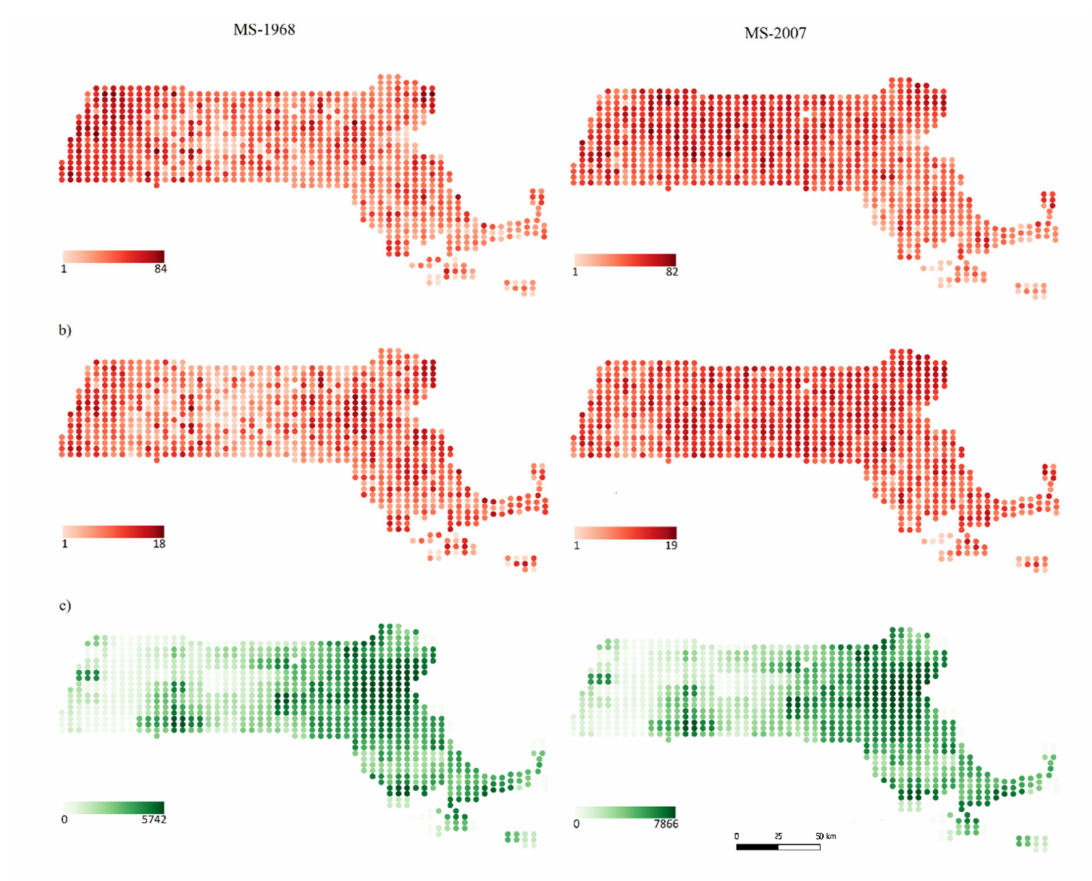
Figure 1. Distribution of ( a ) native species richness, ( b ) alien species richness, and ( c ) human population density in each grid cell (grid cell size approximately 25 km 2 ) in the state of Massachusetts for the first time period MS-1968 (left column) and the second time period MS-2007 (right column).